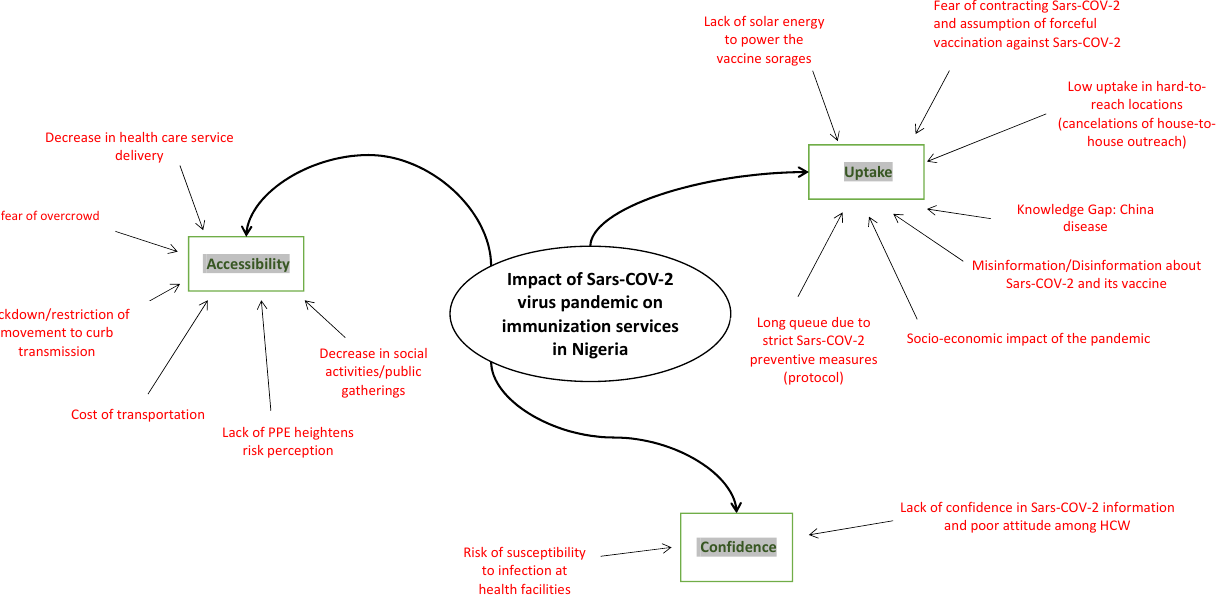
Figure 2. Components of the impact of the COVID-19 pandemic in Nigeria.